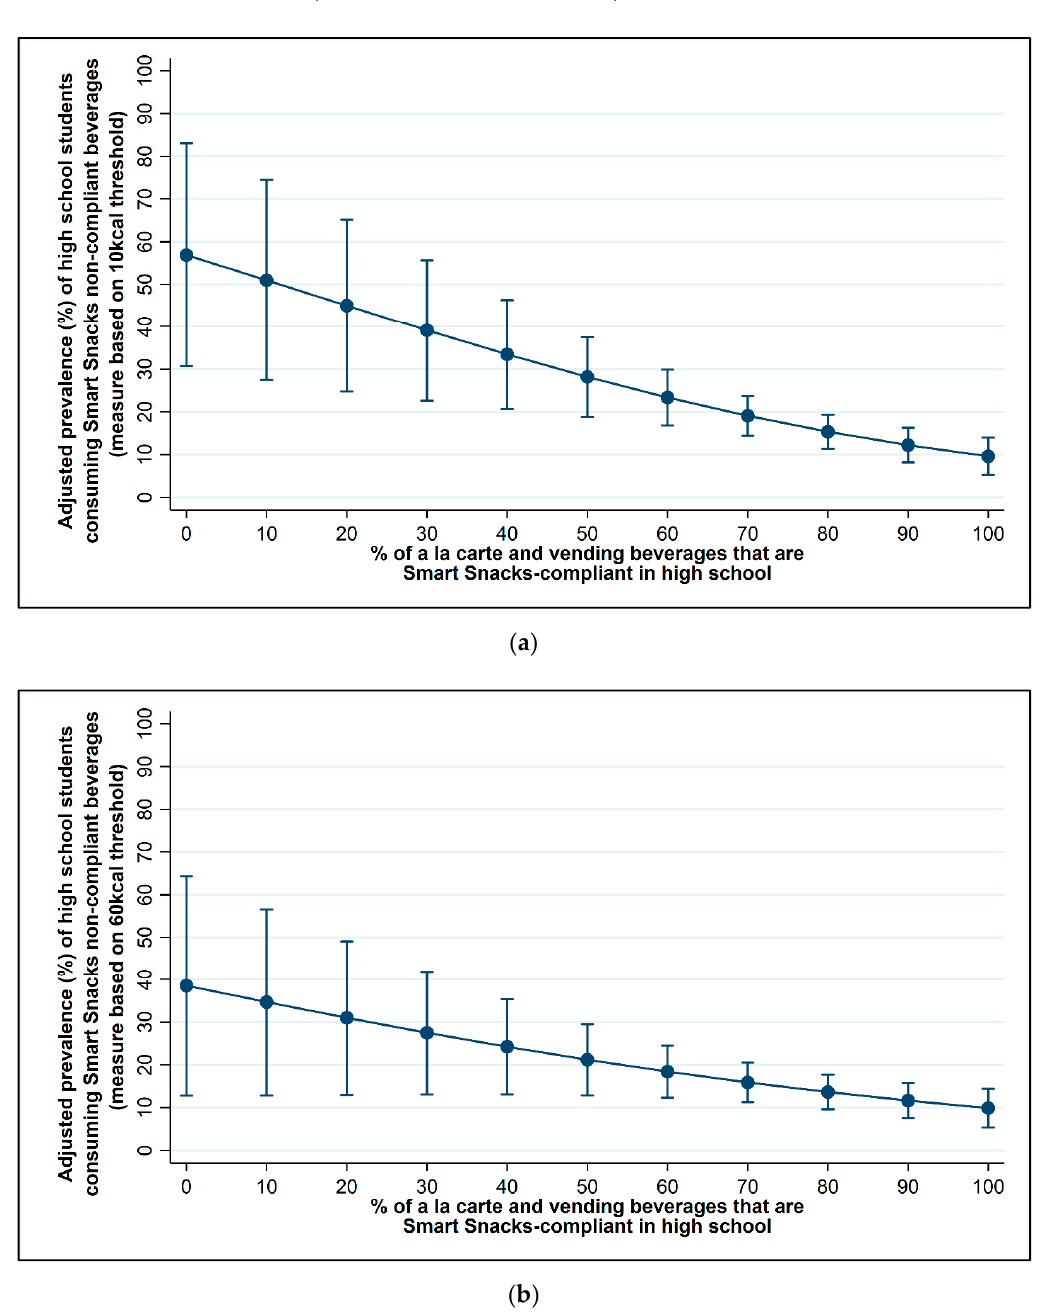
Figure 3. Adjusted prevalence of high school student consumption of non-compliant beverages in school by the percentage of compliant beverages sold in school. The two panels model the adjusted prevalence of student consumption of Smart Snacks non-compliant beverages, after controlling for district, school, and student characteristics at the ( a ) 10 and ( b ) 60 kcal